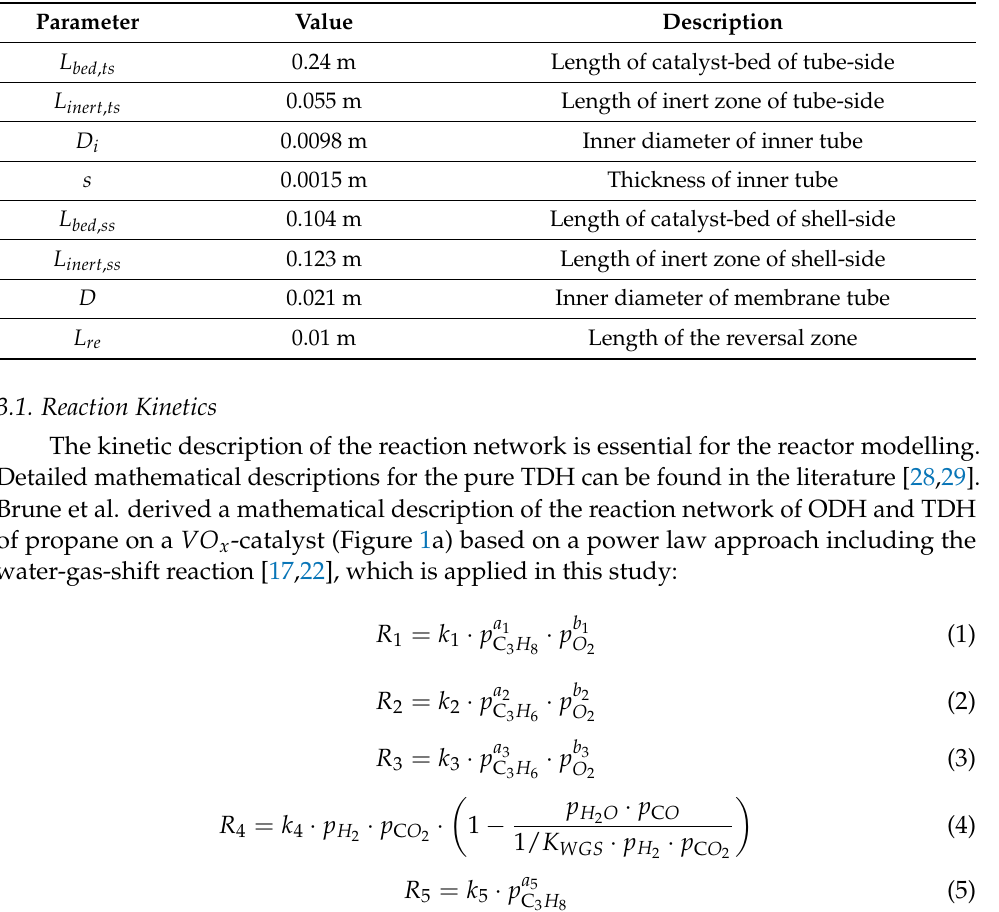
Table 2. Geometrical parameters of the